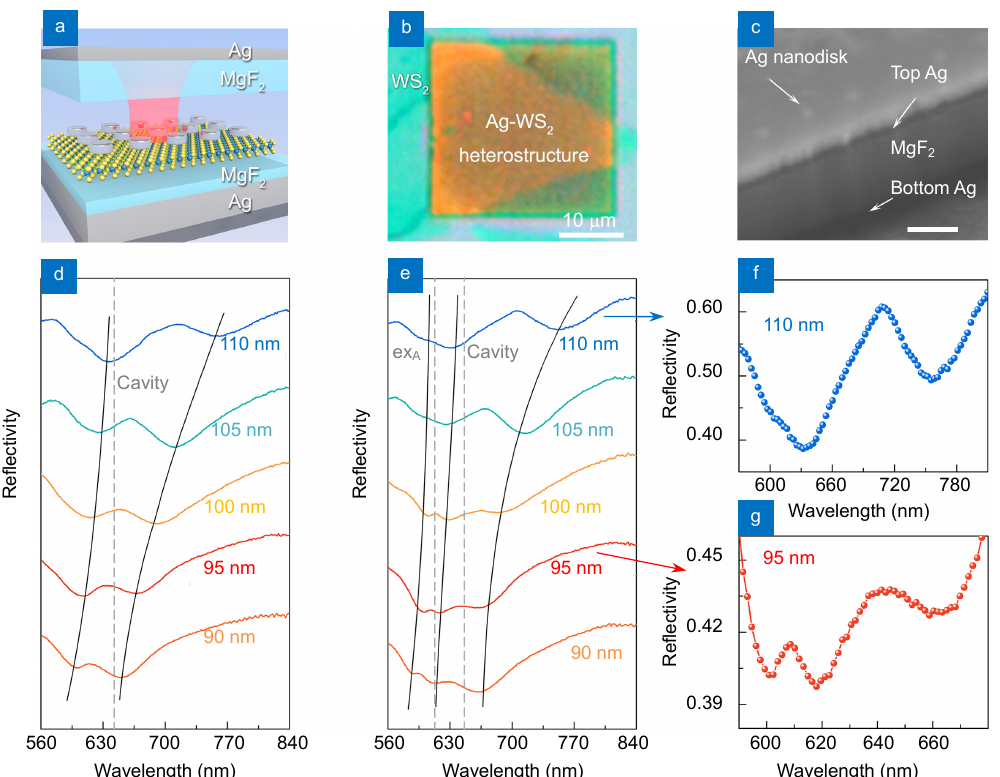
Fig. 2 | Strong coupling in the Ag-WS 2 heterostructure with an optical microcavity. ( a ) Schematic of the optical microcavity with an em- bedded Ag-WS 2 heterostructure. The microcavity is manufactured in a sandwich structure with a 100 nm-thick Ag layer at the bottom, a 185 nm- thick MgF 2 layer in the middle, and a 20 nm-thick Ag layer on the top. ( b ) The reflectivity spectral mapping of the Ag-WS 2 heterostructure with optical microcavity. Here the diameter of Ag nanodisk is 95 nm. Scale bar: 10 μ m. ( c ) Cross section view of the Ag-WS 2 heterostructure with optical microcavity at a tilted angle 52°, scale bar is 150 nm. ( d ) Normal-incidence reflectivity spectra of the Ag nanodisk with different sizes directly embedded in the optical microcavity. The Ag nanodisks couple with the optical microcavity, which generates two new hybrid modes with the bandwidth smaller than plasmon resonances of bare Ag nanodisks. ( e ) Normal-incidence reflectivity spectra of the Ag-WS 2 heterostructure with optical microcavity. Three different hybridized modes, as the upper branch, middle branch, and lower branch are observed in reflectivity spectra, which are indicated by black solid lines. Vertical gray dashed lines respectively represents the WS 2 A-exciton energy and the resonance energy of bare optical microcavity. ( f , g ) Expanded views of reflectivity spectral features of the heterostructure with the Ag nanodisk diameter of 110 nm (f) and 95 nm